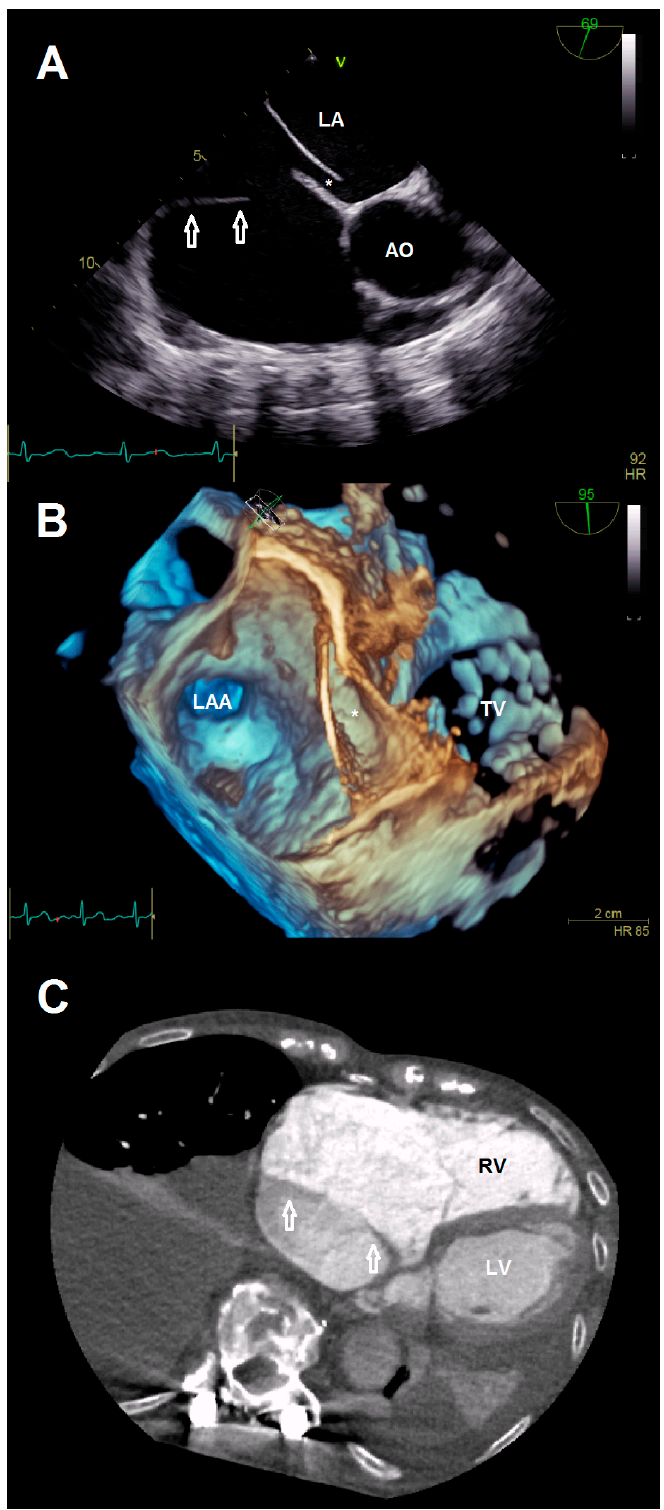
Figure 2. ( A ) Anatomical relationship between the additional membrane (arrows) and present patent foramen ovale (*). ( B ) 3-D view showing the patent foramen ovale (*). ( C ) Cardiac computed tomography visualizing the cor triatriatum dexter (arrows) for procedural planning. Abbreviations: AO, aorta; LA, left atrium; LAA, left atrial appendage; LV, left ventricle; RV, right ventricle; TV, tricuspid valve.